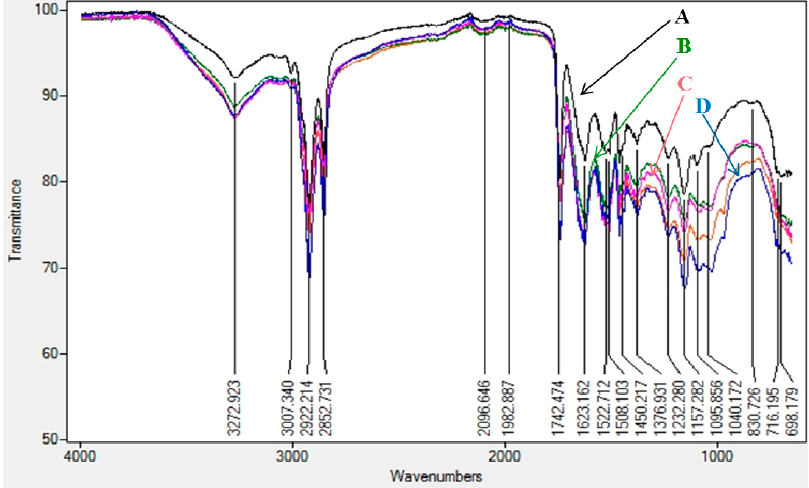
Figure 1. The infrared spectrum of ( A ): control burger, ( B ): 1% Picochlorum burger, ( C ): 1% Isochrysis burger and ( D ): 1% Chlorella burger.